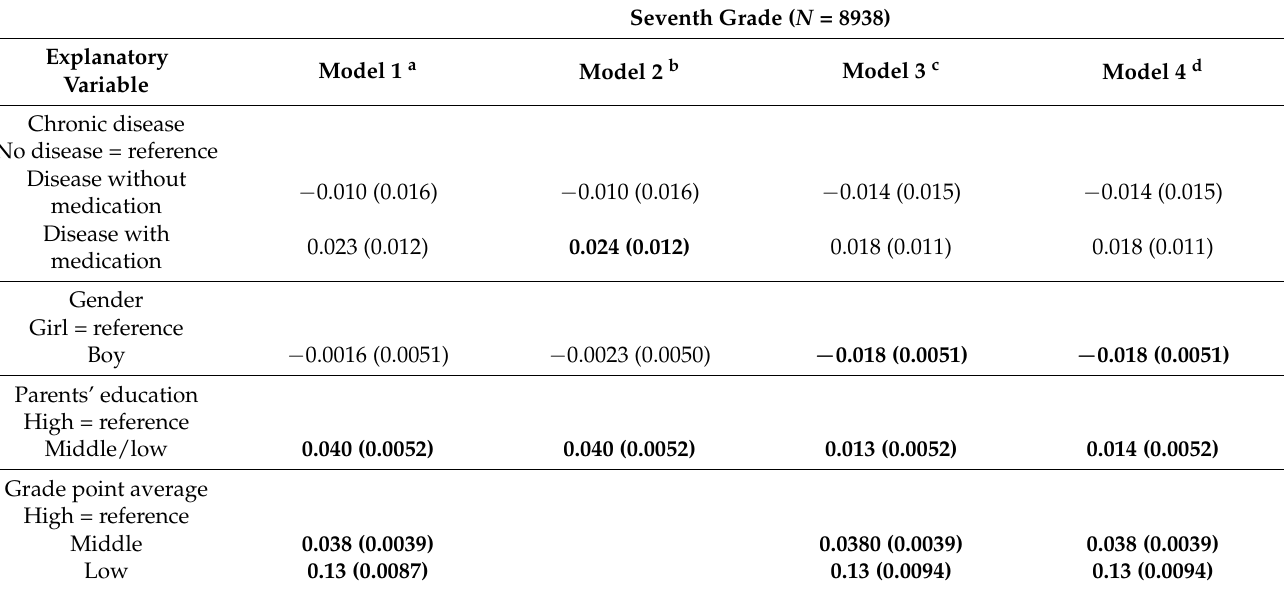
Table A6. The delayed start of upper-secondary school: the analyses of the logistic models of Table 4 presented as average marginal effects. Standard deviations in